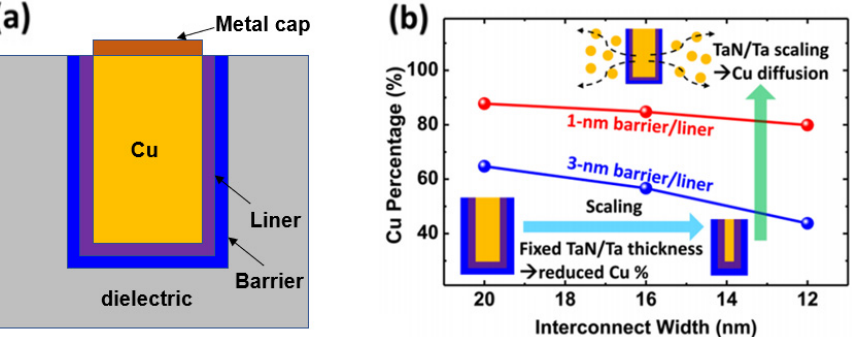
Figure 6. ( a ) Typical metallization of a Cu line with a barrier, liner, and metal cap. ( b ) Scaling challenges for the barrier and liner; in particular, a lower cross-sectional area is occupied by Cu with scaling [41].